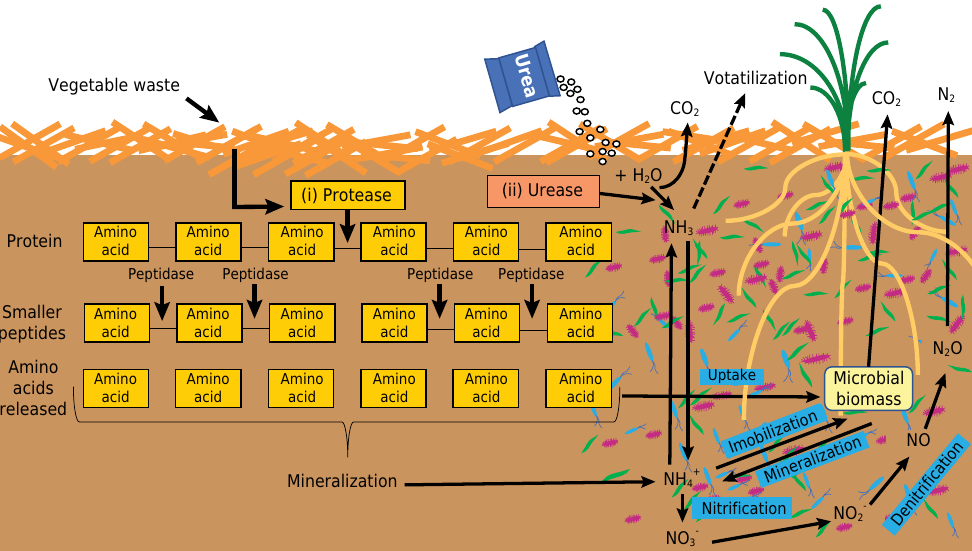
Figure 2. Nitrogen-binding soil enzymes on plant residue